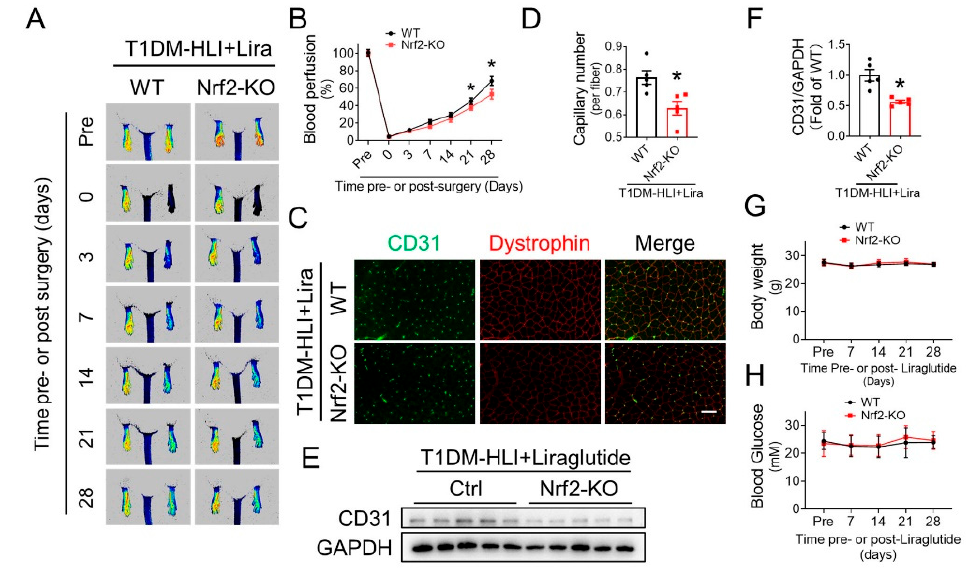
Figure 7. Nrf2 deficiency attenuates the beneficial effect of liraglutide in improving blood perfusion and angiogenesis in ischemic hindlimbs of T1DM mice. The proangiogenic effect of liraglutide in ischemic tissue was investigated in WT-T1DM and Nrf2-KO-T1DM mice. Blood perfusion in ischemic hindlimb was evaluated using a PeriCam PSI ( A ), and quantified using Image J ( B ). At the 28th day after HLI surgery, capillaries in gastrocnemius muscle tissue of ischemic hind limbs were detected by CD31 staining ( C ), and presented as CD31-positive capillaries per muscle fiber ( D ). CD31 content in ischemic gastrocnemius muscle was also detected by Western blot ( E ) and quantified using Imagequant ( F ), and GAPDH was used as loading control. Blood glucose ( G ) and body weight ( H ) were monitored before and after HLI surgery. Data shown in graphs presented as mean ± S.D. n = 5 mice per group. * p < 0.05 vs. T1DM-HLI WT mice. Bar = 100 µm. T1DM, type 1 diabetes mellitus.